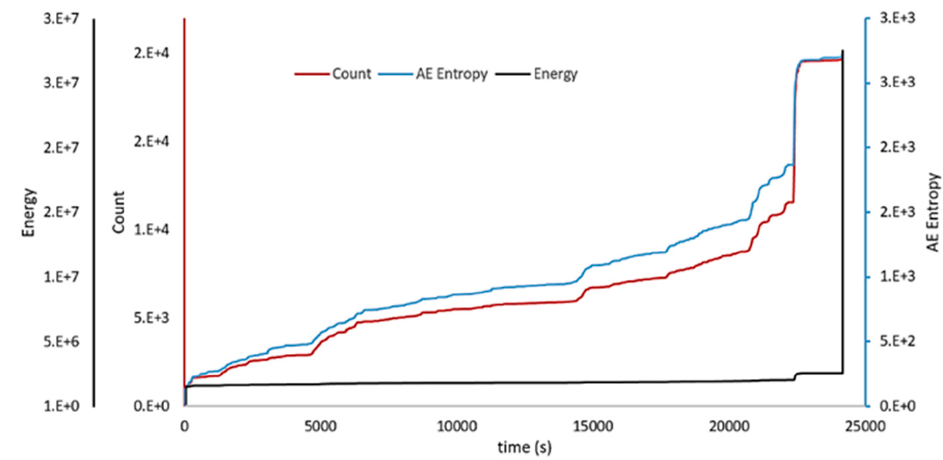
Figure 19. Comparison of the cumulative trend for the fatigue test.